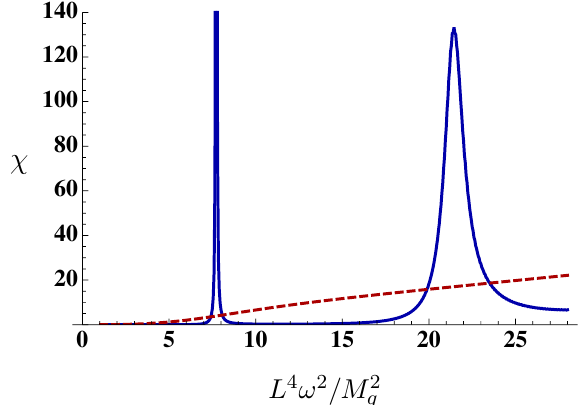
Figure 5. Spectral function (with arbitrary normalisation) of the gauge theory operator dual to the (cid:12) 3 scalar for (cid:3) = 1 (dashed, red curve) and (cid:3) = 1 = 10 (solid, blue